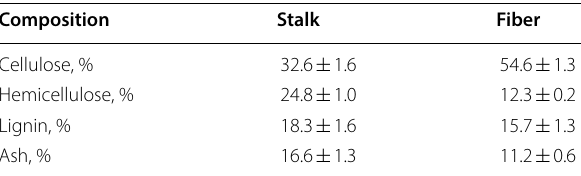
Table 1 Composition of the M. pinnata stalks and fibers extracted from the plant Composition